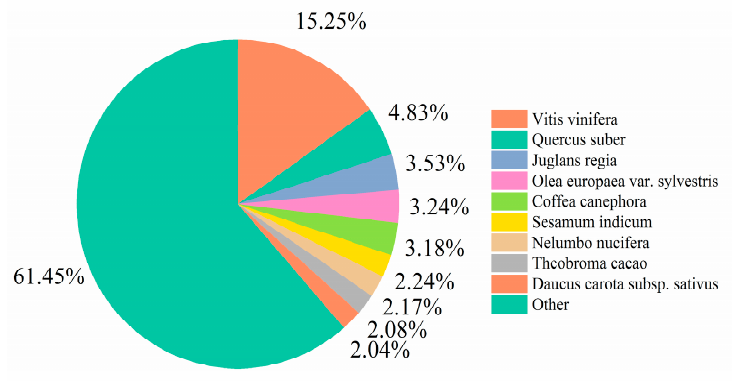
Figure 3. Species distribution of the R. liliiflorum unigenes in the Nr database.